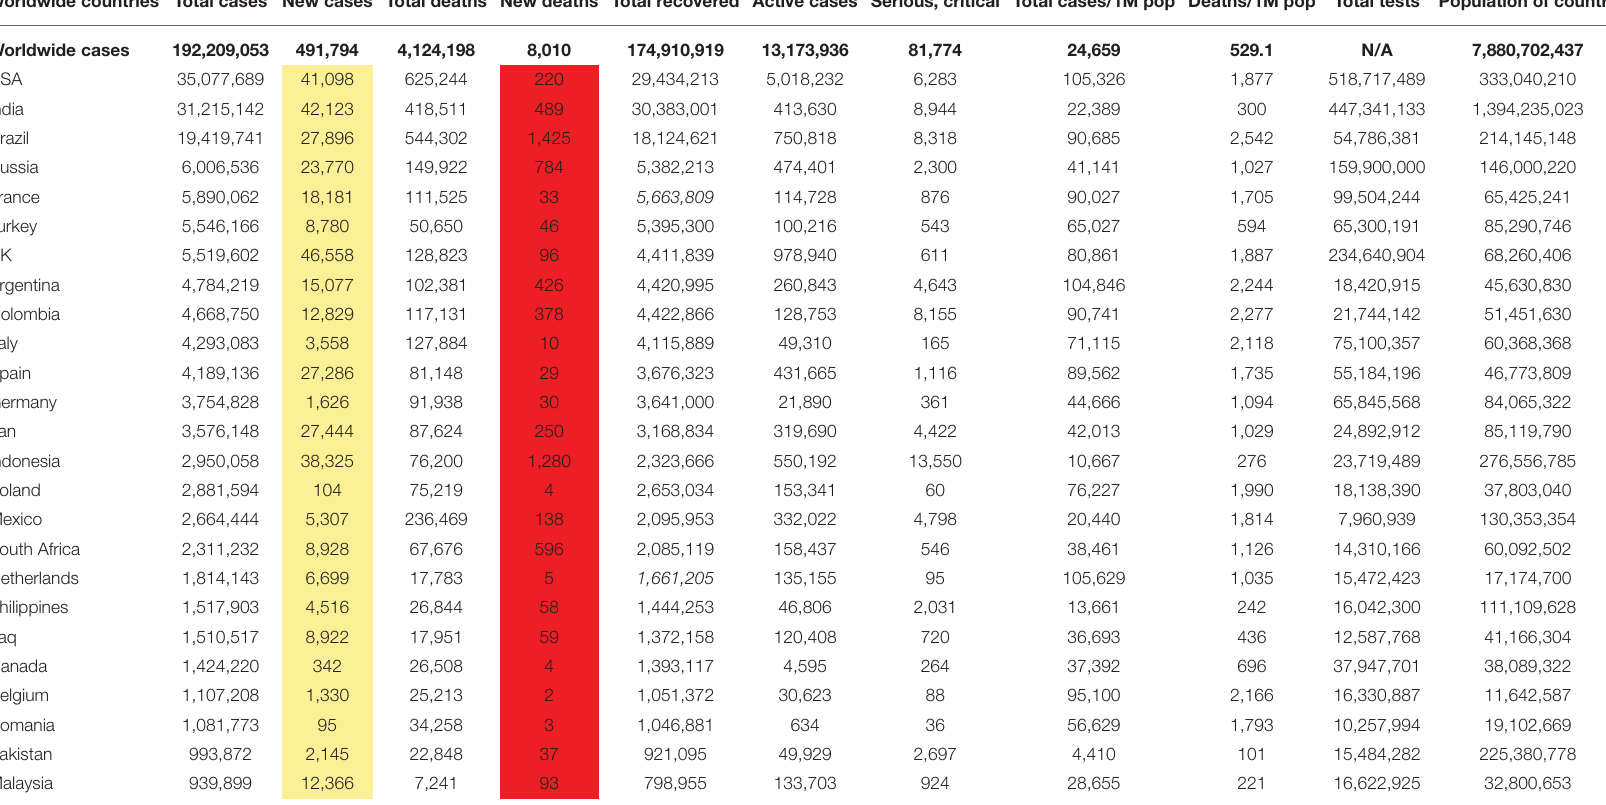
TABLE 5 | Worldwide COVID-19 cases and the top 30 most affected countries, as of July 19, 2021. Worldwide countries Total cases New cases Total deaths New deaths Total recovered Active cases Serious, critical Total cases/1M pop Deaths/1M pop Total tests Population of country